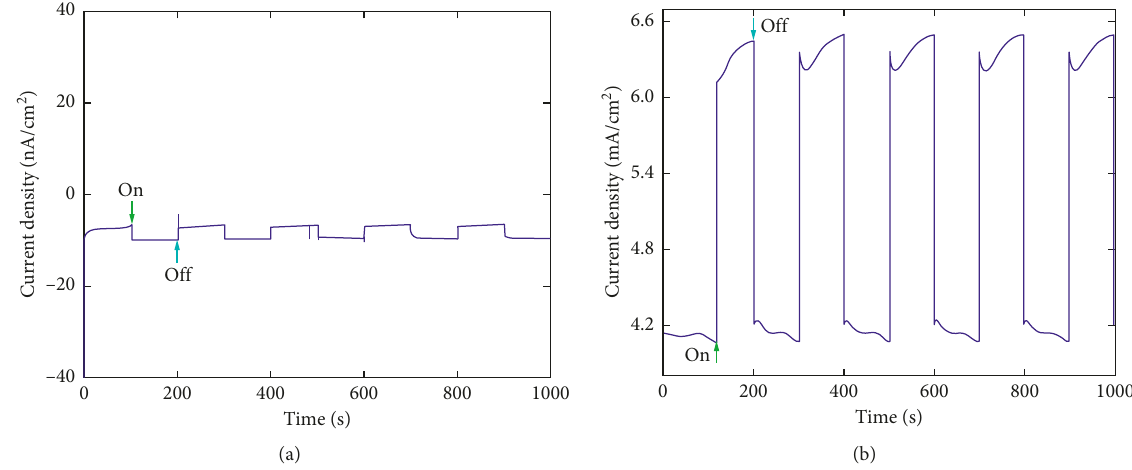
Figure 4: (a) − 0.3V and (b) 0.3V biased transient photocurrent graphs for Cu